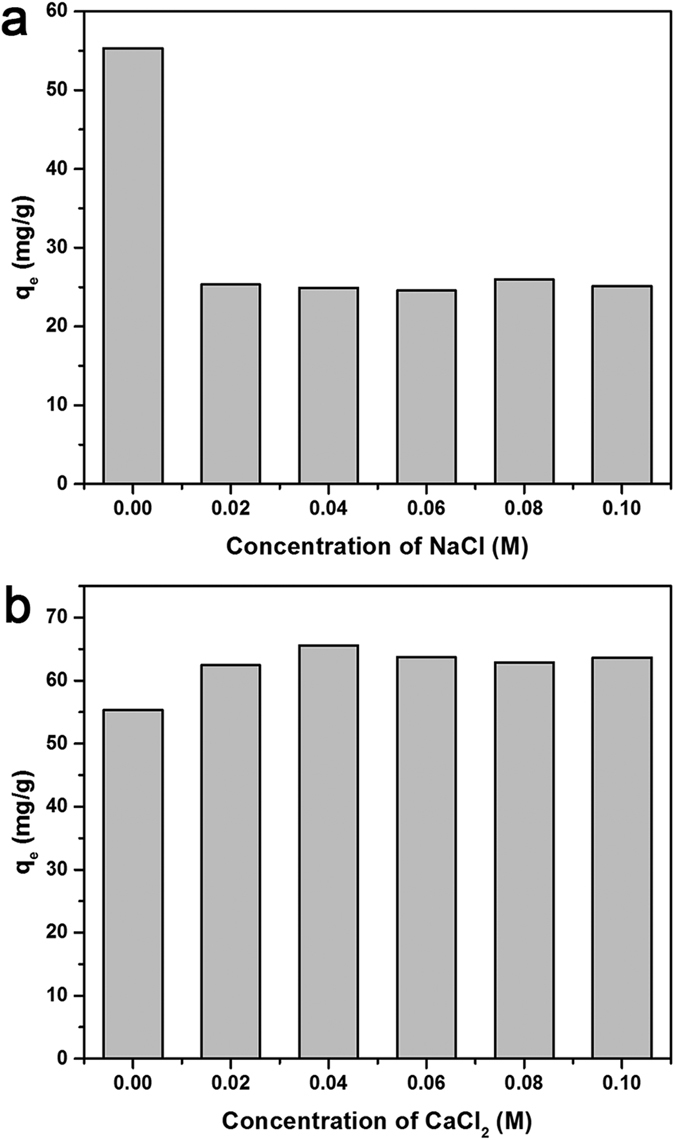
Effects of the ionic strength on the adsorption of TC by CLDHs/BC: (a) effects of NaCl and (b) effects of CaCl2.